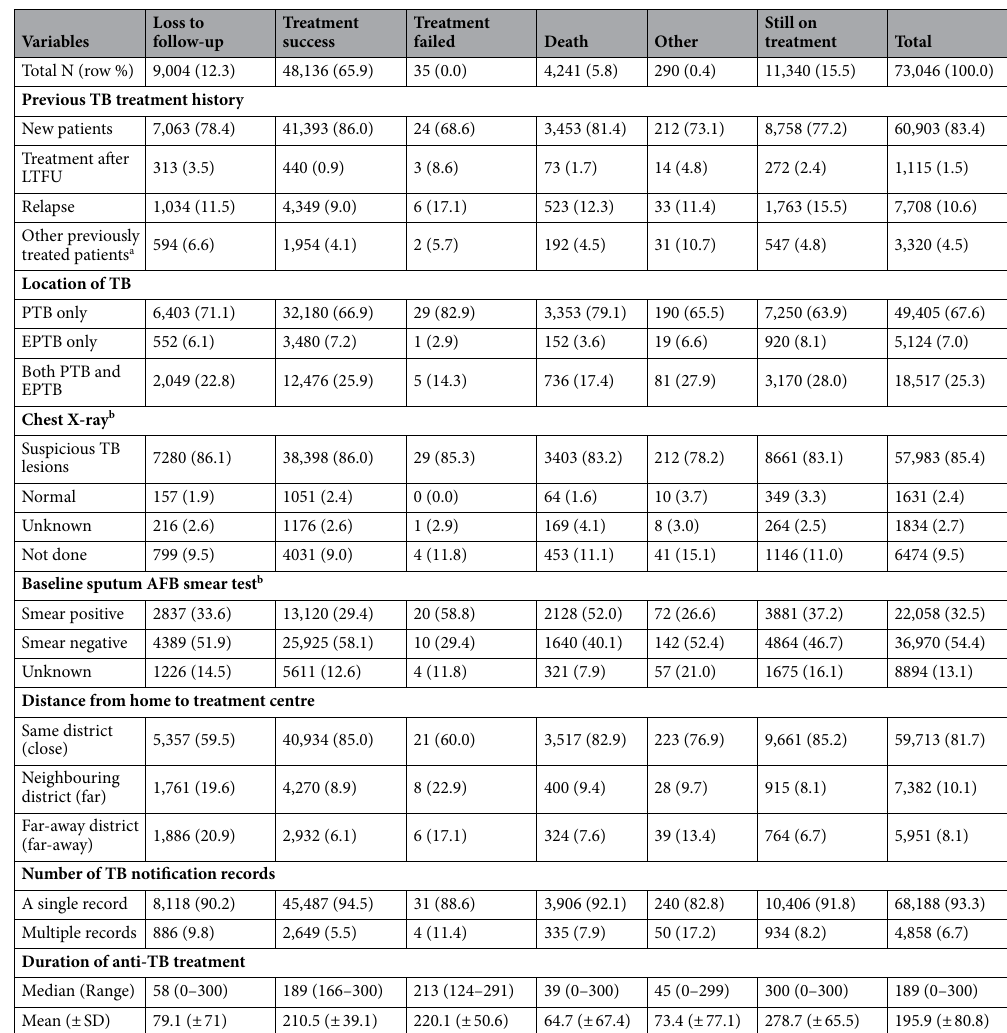
Table 3. Clinical and Treatment related characteristics of enrolled tuberculosis patients, categorized by treatment outcome. a Composed of ‘treatment after failure patients’ and ‘other previously treated patients’ whose outcome of previous treatment was unknown or undocumented. b Patients with pulmonary tuberculosis were analysed. N number, LTFU loss to follow-up, TB tuberculosis, PTB pulmonary tuberculosis, EPTB extra- pulmonary tuberculosis, SD standard deviation, AFB acid-fast bacillus. Data are presented as n (column